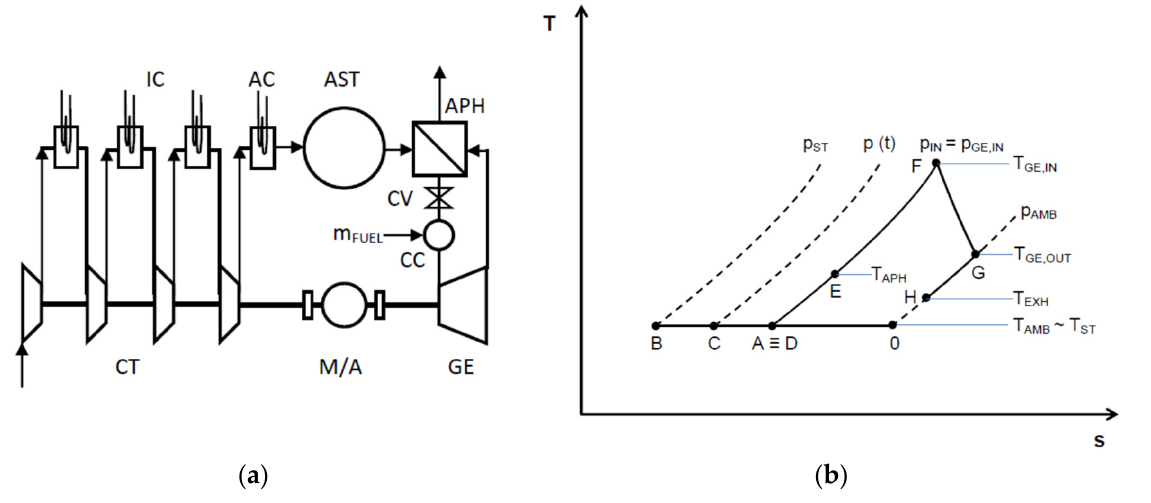
Figure 1. Proposed D-CAES system: ( a ) Plant lay out; ( b ) Representation on a T-s diagram of processes occurring in the D-CAES plant under